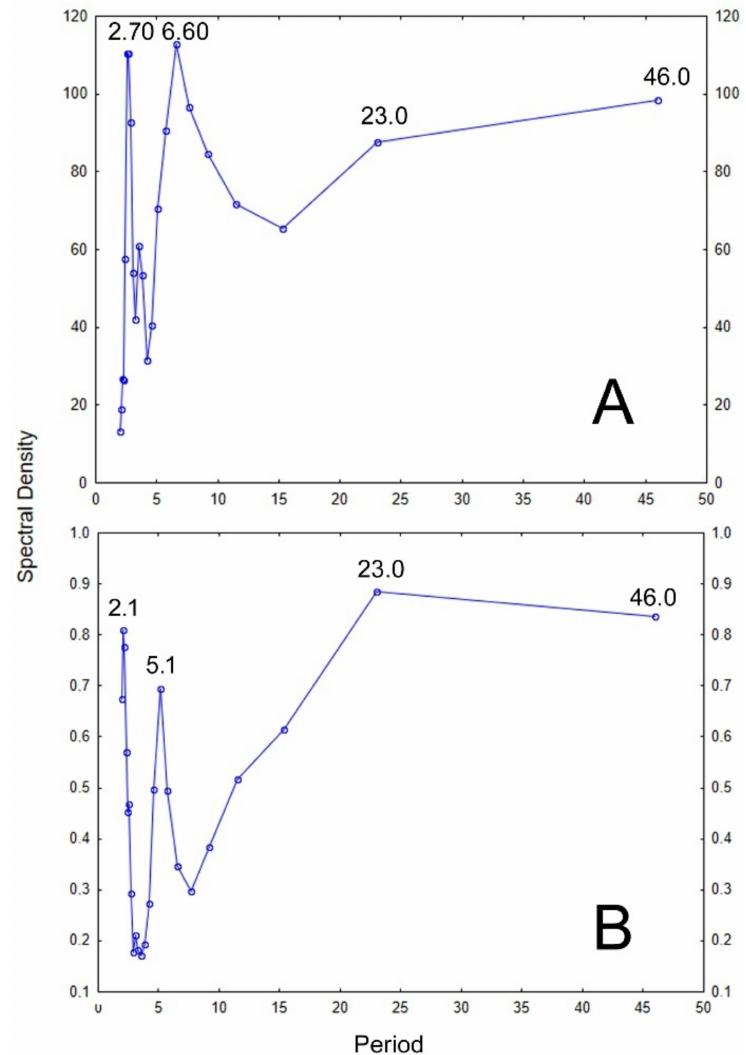
Figure 3. Results of spectral analysis of two timeseries: ( A ) The abundance of small mammals in the Tyumen Region, 1962–2007; ( B ) The index of abundance of I. apronophorus in the same area, 1962–2007. Both graphs are based on the relative, not absolute, measures of